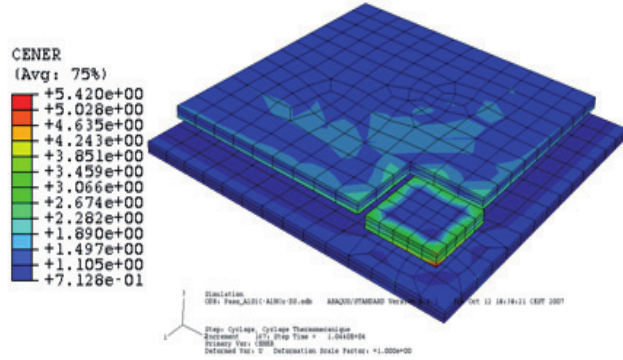
Fig. 16. Maximal principal stress distribution in silicon chip with DS connection (MPa).